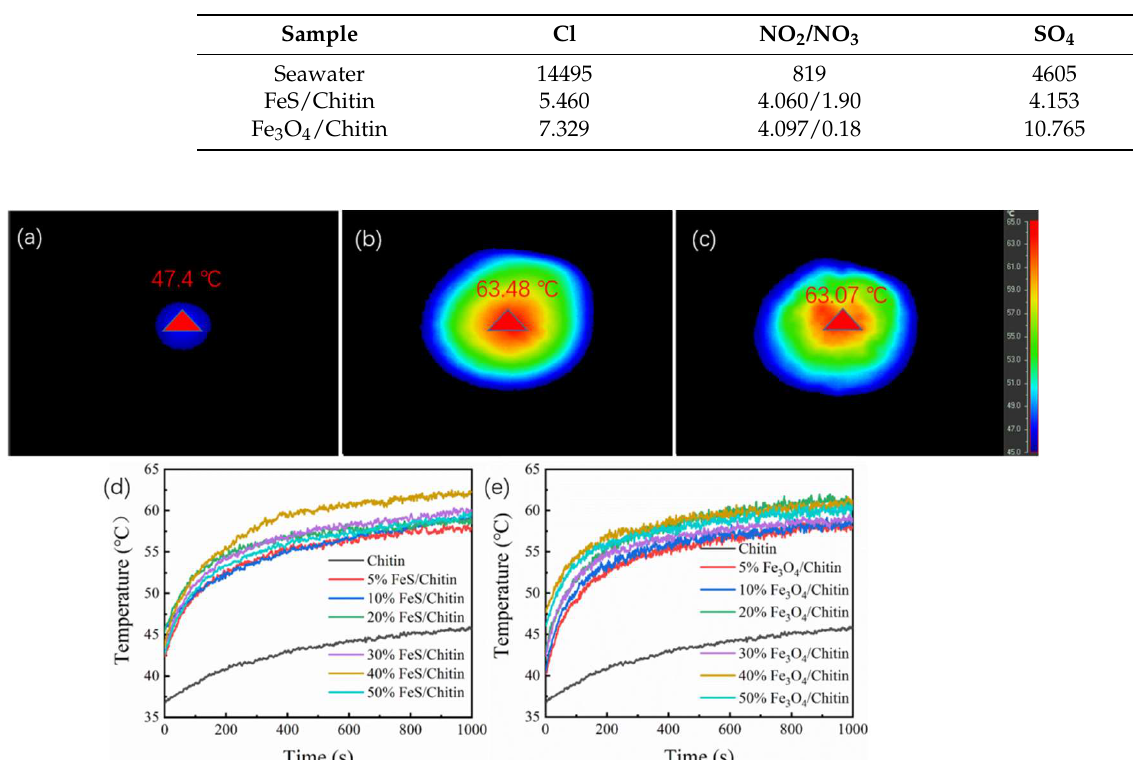
Figure 6. The desalination efficiency of blank, chitin, FeS/chitin and Fe 3 O 4 /chitin films ( a ) and a graph of evaporation performance under the sun ( b ). Table 2. Desalinated water salinity results.